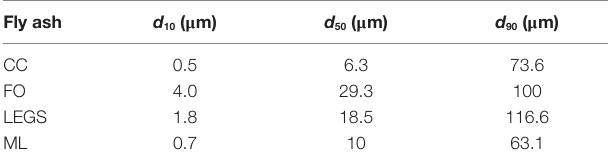
TaBle 2 | Fly ash particle size distributions as measured by laser particle size analysis, based on a single